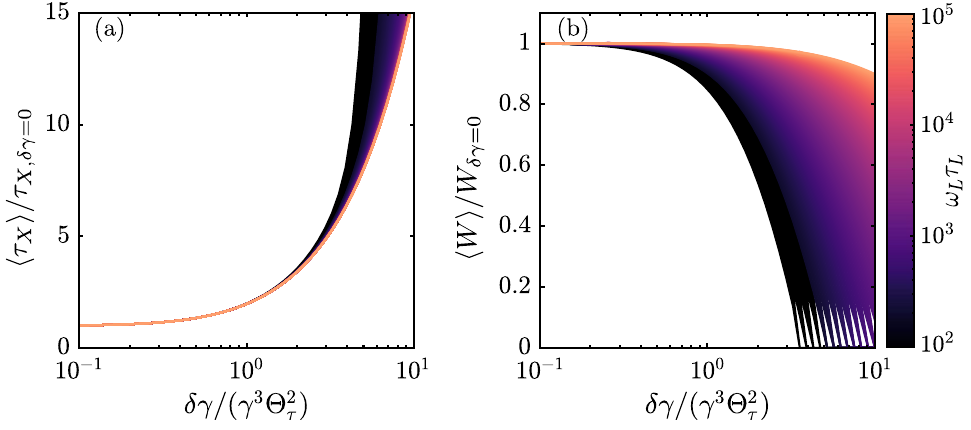
α P max . The electron mirror is GDD matched =